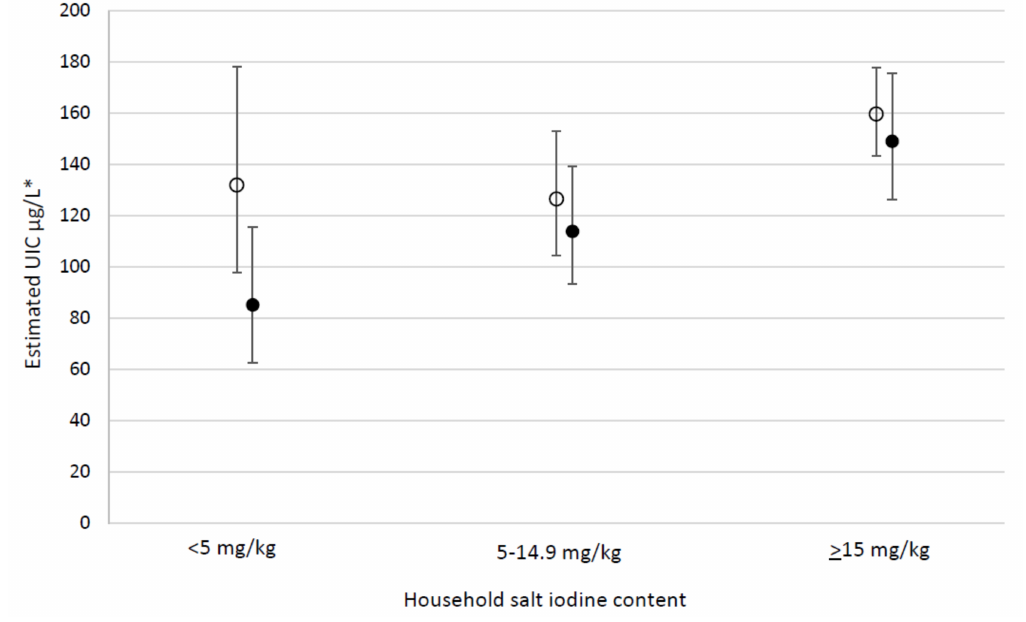
Figure 1. Multiple regression analysis including interaction with urban/rural residence type, to estimate predicted UIC ( µ g/L) among WRA according to household salt iodine category (mg/kg) in